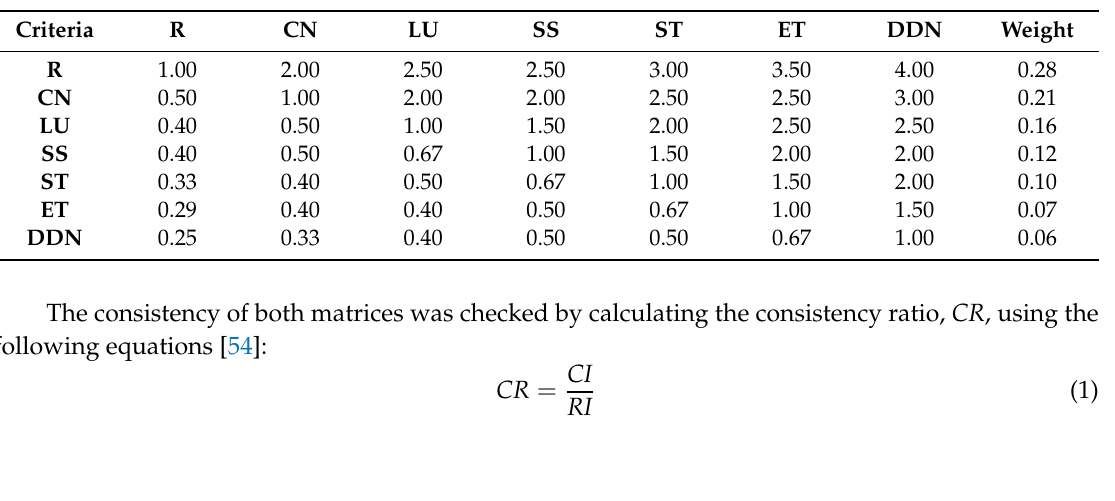
Table 4. AHP pairwise comparison matrix for agricultural rainwater harvesting suitability (ARWHS) index for the West Bank case